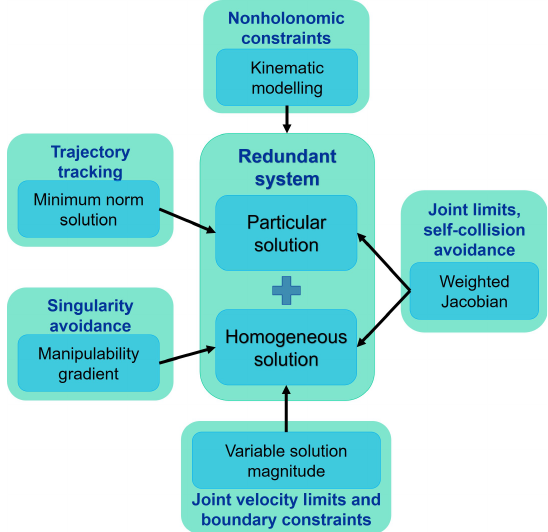
Figure 1. Summary of the proposed motion planning